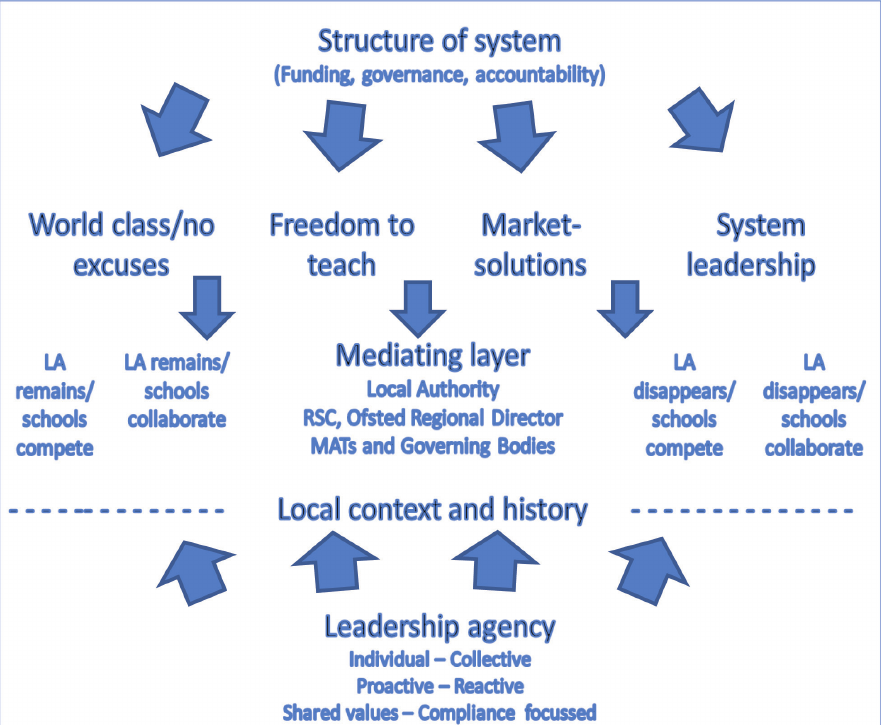
Figure 2: The interplay between system structures, policy narratives, the mediating layer, local context, and leadership agency determines the level of alignment between local